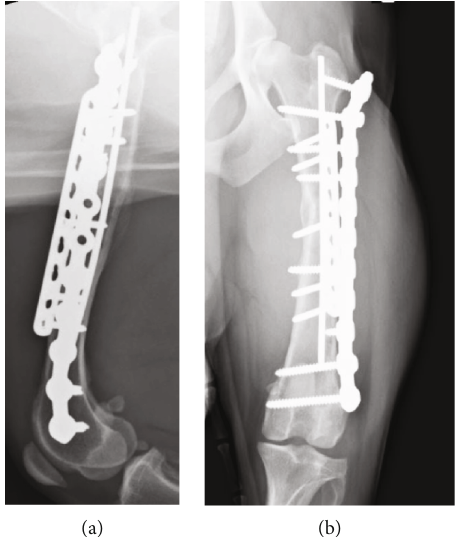
Figure 4: Postoperative radiographs. Postoperative bone healing was good, and cortical bone continuity was observed four months postoperatively, con fi rming that bone healing had been achieved. (a) Lateral view at four months after surgery. (b) Anterior-posterior view at four months after